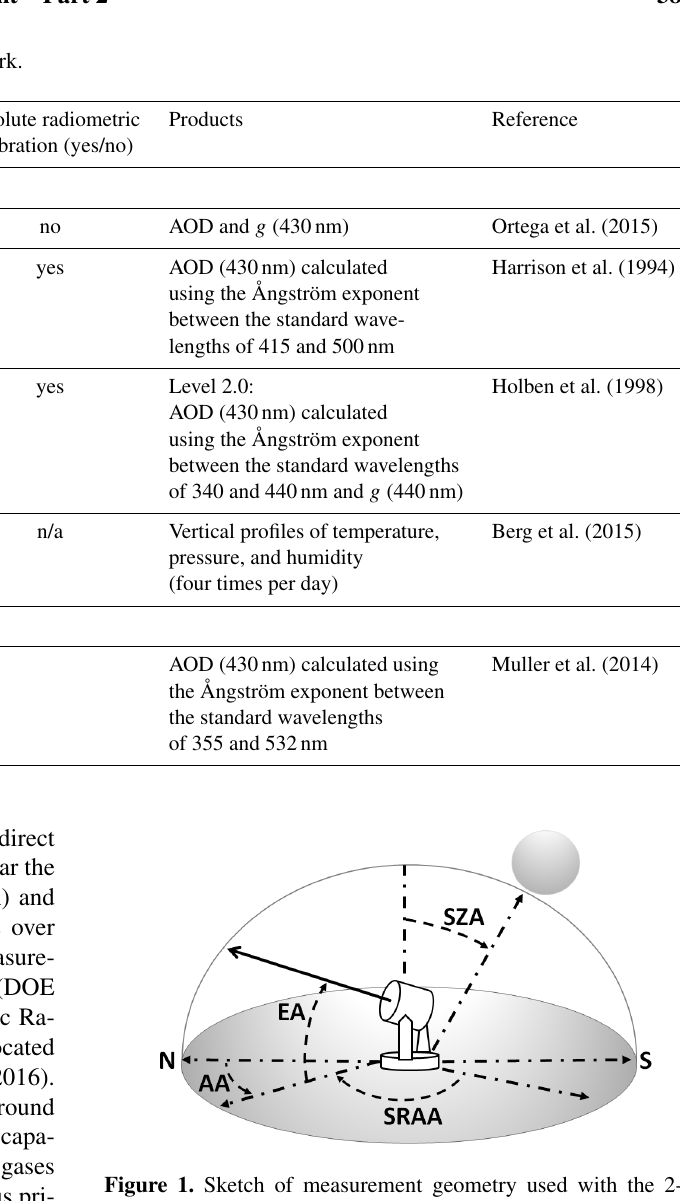
Figure 1. Sketch of measurement geometry used with the 2-D- MAX-DOAS. The solid line coming out from the telescope repre- sents the azimuth angle (AA) with respect to north, characterized by the elevation angle (EA) and solar relative azimuth angle (SRAA). SZA is the solar zenith